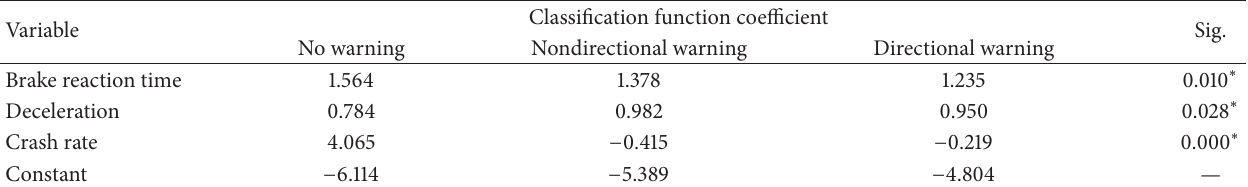
Table 1: Results of discriminant